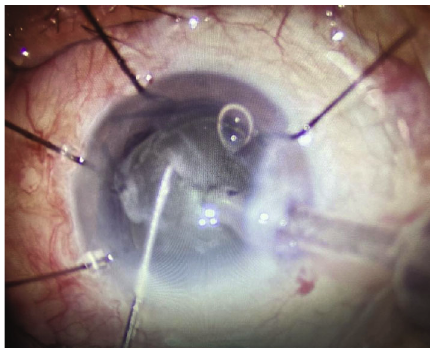
Figure 2: The phacoemulsi fi cation process was completed with the help of capsule hooks (the capsule was fi lled with the viscoelastic agent to prevent vitreous prolapse).